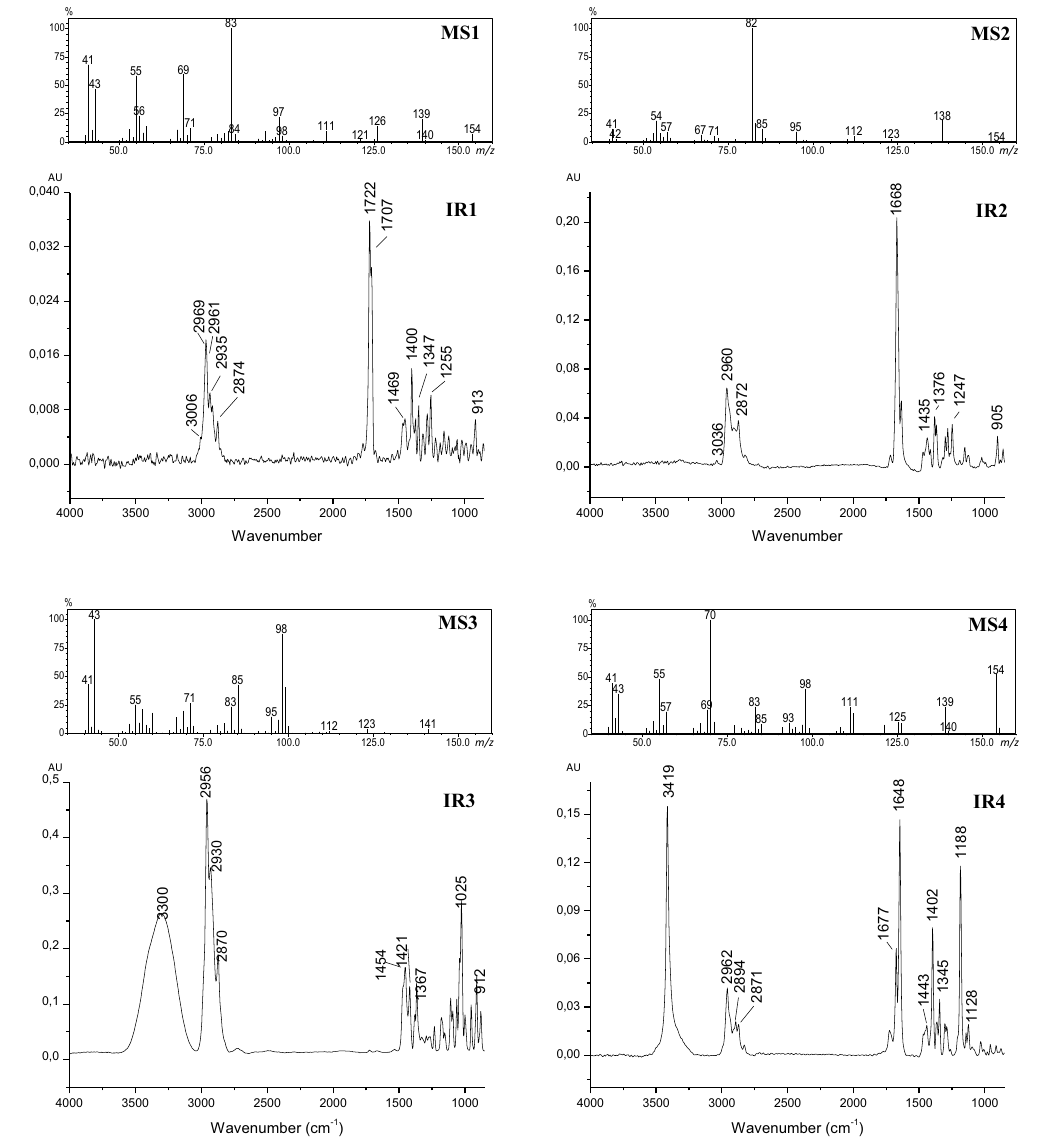
Figure 3. Mass and infrared spectra of the naturally occurring compounds 1 – 4 from Homalinotus depressus males extracts. Mass spectra: MS1) epoxyisophorone ( 1 ), MS2) isophorone ( 2 ), MS3) homalinol ( 3 ), MS4) 2-hydroxyisophorone ( 4 ). Infrared spectra: IR1) epoxyisophorone ( 1 ), IR1) isophorone ( 2 ), IR3) homalinol ( 3 ), IR4) 2-hydroxyisophorone ( 4